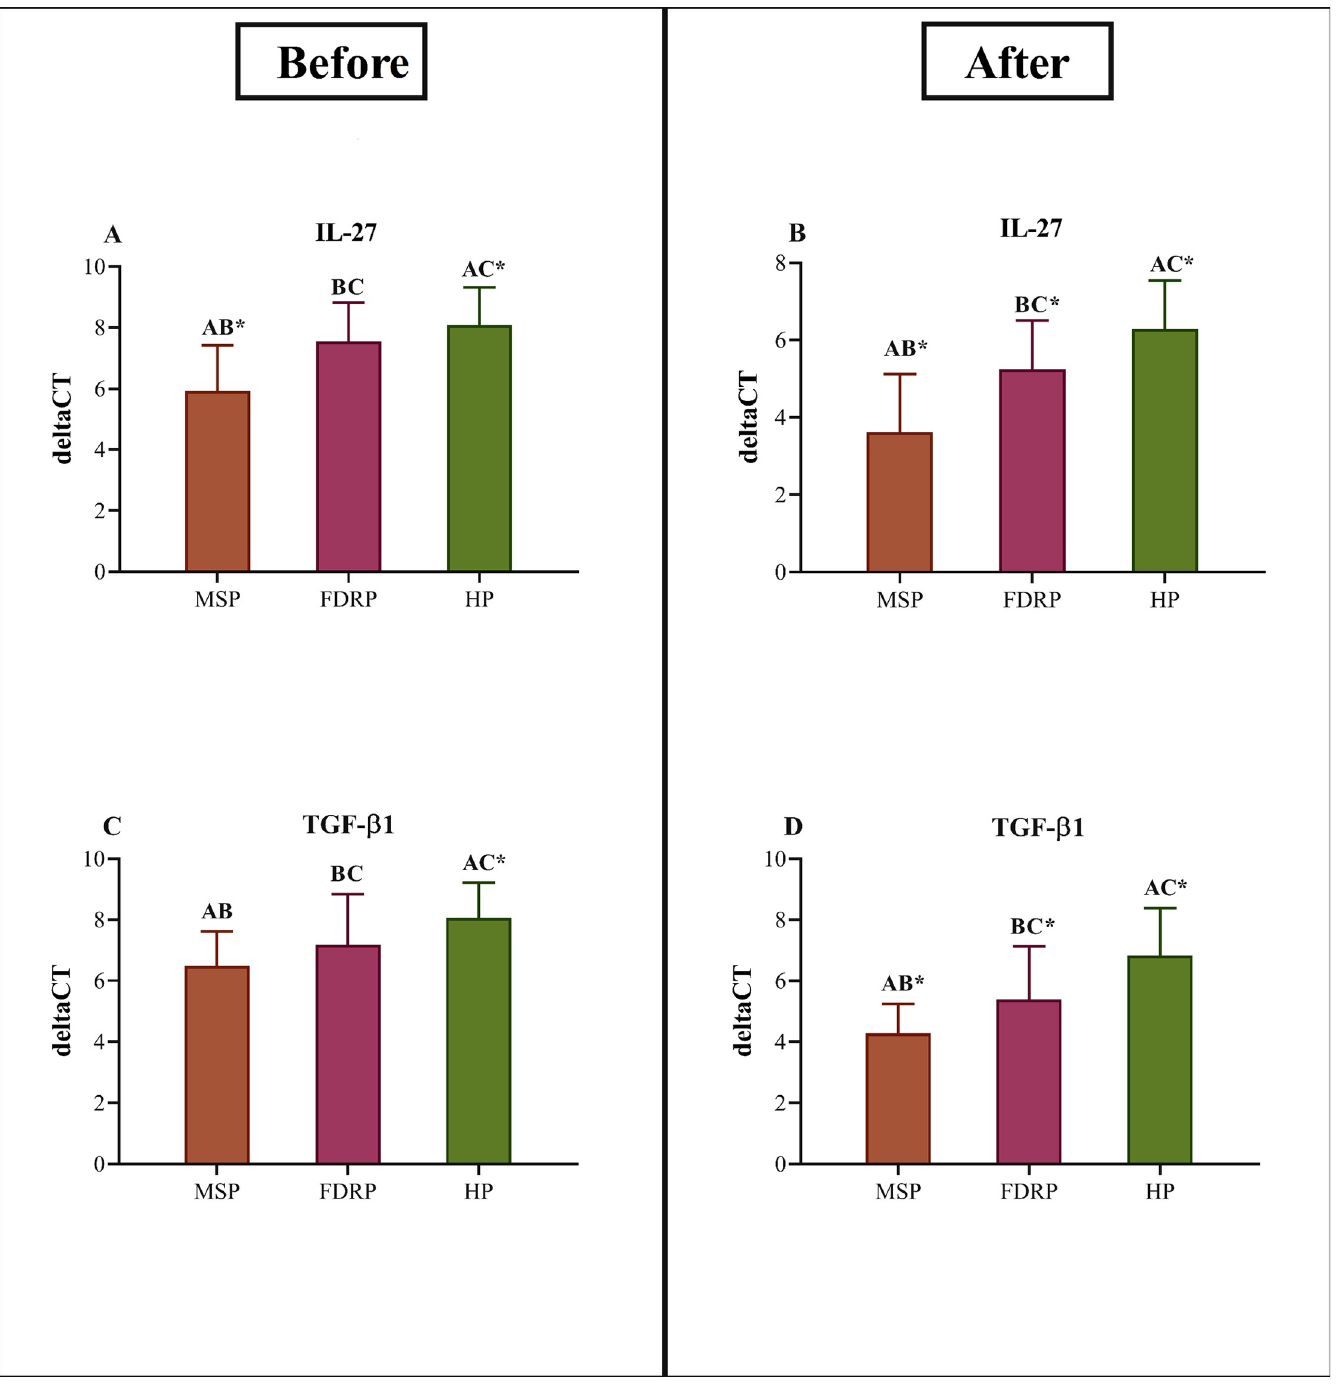
Fig 2. The outcome of IL-27 & TGF- β 1 mRNA expression analysis. Impacts of vitamin D 3 administration on mRNA expression of anti-inflammatory cytokines (n = 25 per group). (A-D) IL-27 and TGF- β 1 mRNA expression surfaces of Multiple Sclerosis Participants (MSP), First Degree Relatives Participants (FDRP), and Healthy Participants (HP). In comparison, among groups, MSP, FDRP, and HP have been identified by A, B, and C, respectively. One-way ANOVA and then, post-hoc Tukey’s test, was applied. The data were then represented as mean ± standard deviation (SD), and � P < 0.05 was considered as statistically significant between groups.